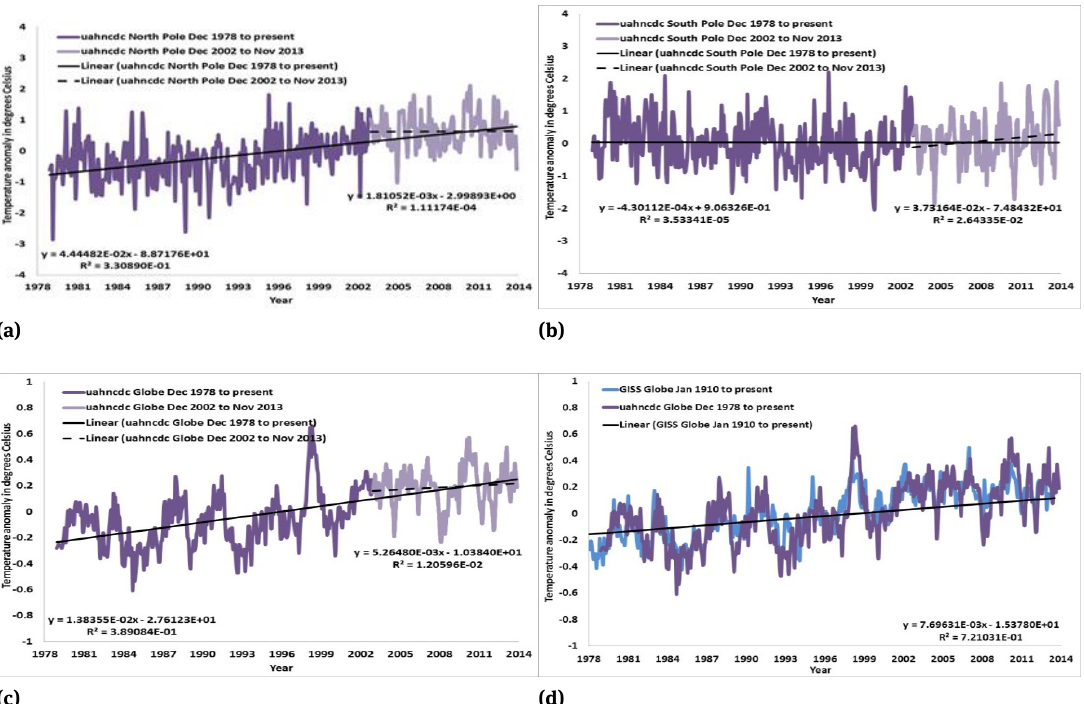
Fig. 4. a, b, c: Measured temperatures for the North and South poles and the globe (from NSSTC [9]). Data analysed since 1978 and over the last 11 years; d: comparison of global temperatures measured (from NSSTC [9]) and reconstructed (from NASA-GISS [4]).